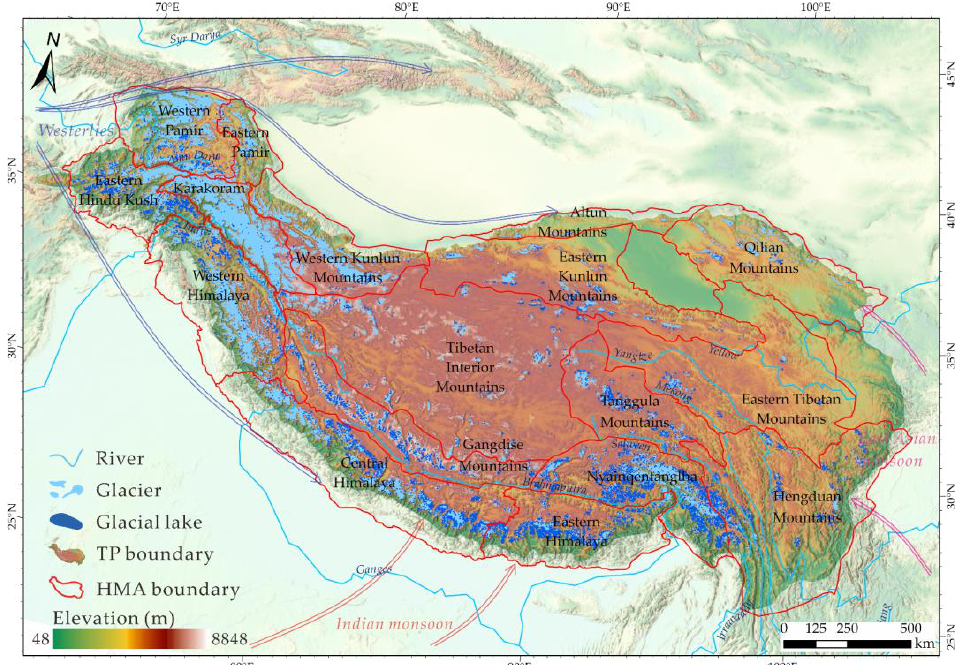
Figure 1. Distribution of glaciers, glacial lakes and major rivers on the Tibetan Plateau (TP). The TP was divided into 17 mountains (http://geo.uzh.ch/~tbolch/data/regions_hma_v03.zip (accessed on 22 November 2022)) [3]. The large-scale atmospheric circulations are also included. The terrain basemap is sourced from ESRI.